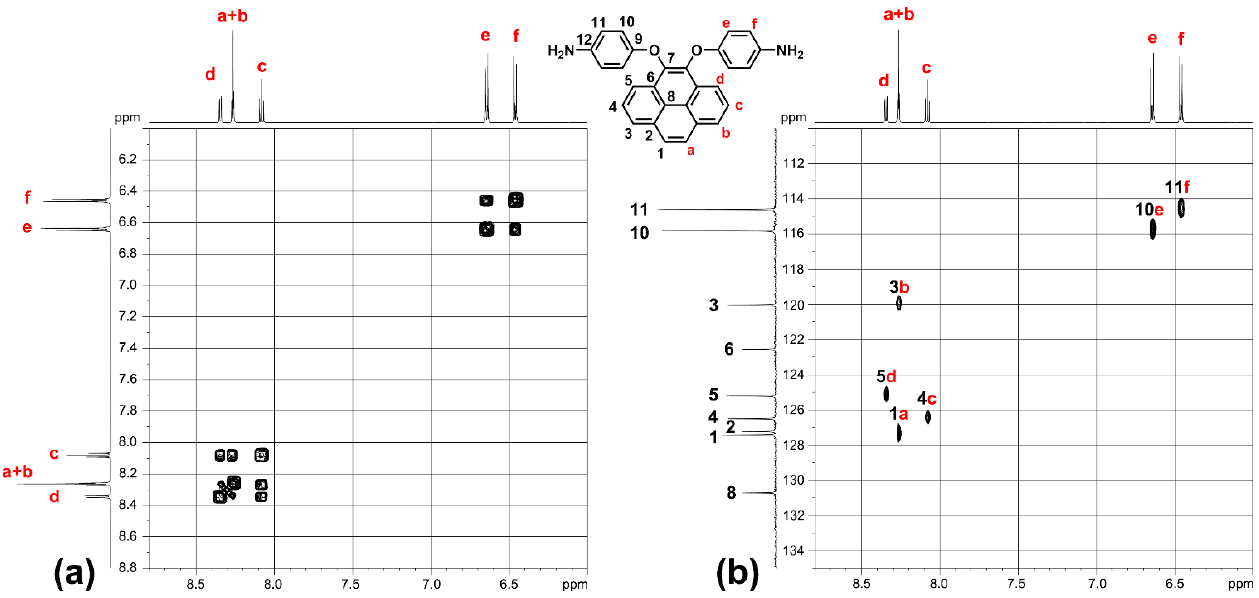
Figure 3. ( a ) H-H COSY and ( b ) C-H HSQC NMR spectra of target monomer 3 in DMSO-d 6 .